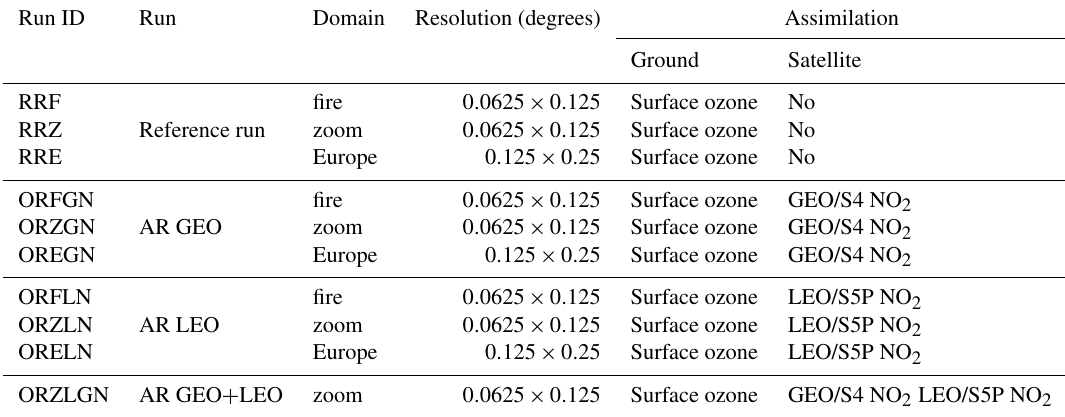
Table 1. Overview of assimilation run configurations. RR: reference run; OR: assimilation run; F: fire domain; Z: zoom domain; E: European domain; GN: GEO satellite; LN: LEO satellite; LGN: LEO and GEO